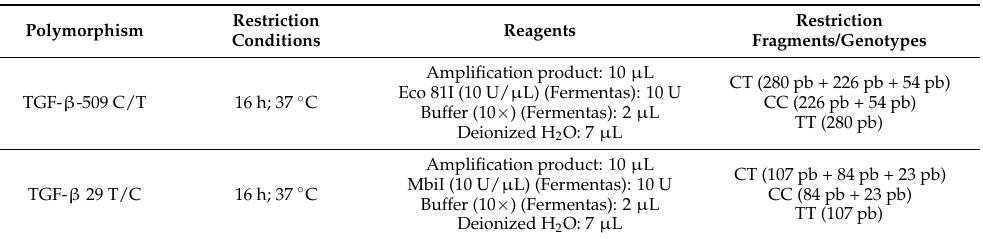
Table 12. Restriction conditions, reagents, and restriction fragments/genotypes for TGF- β polymor-